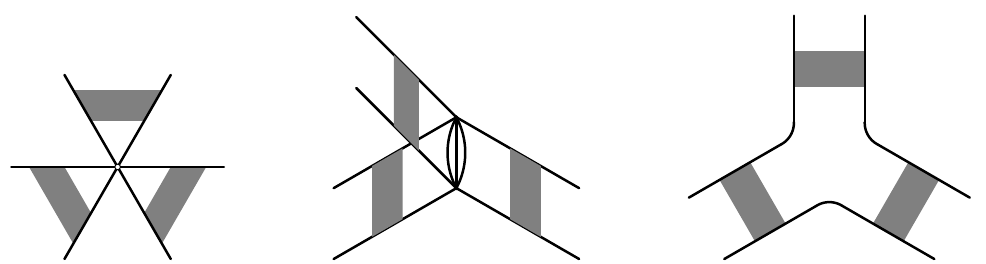
Figure 12. The three types of diagrams contributing to the bare expansion of the six-point couplings in the large- N limit at all order in the coupling constants. The black circles represent wheel vertices and the white circles can be any of the I i interactions (including the wheel). The grey squares represent the full forward four-point